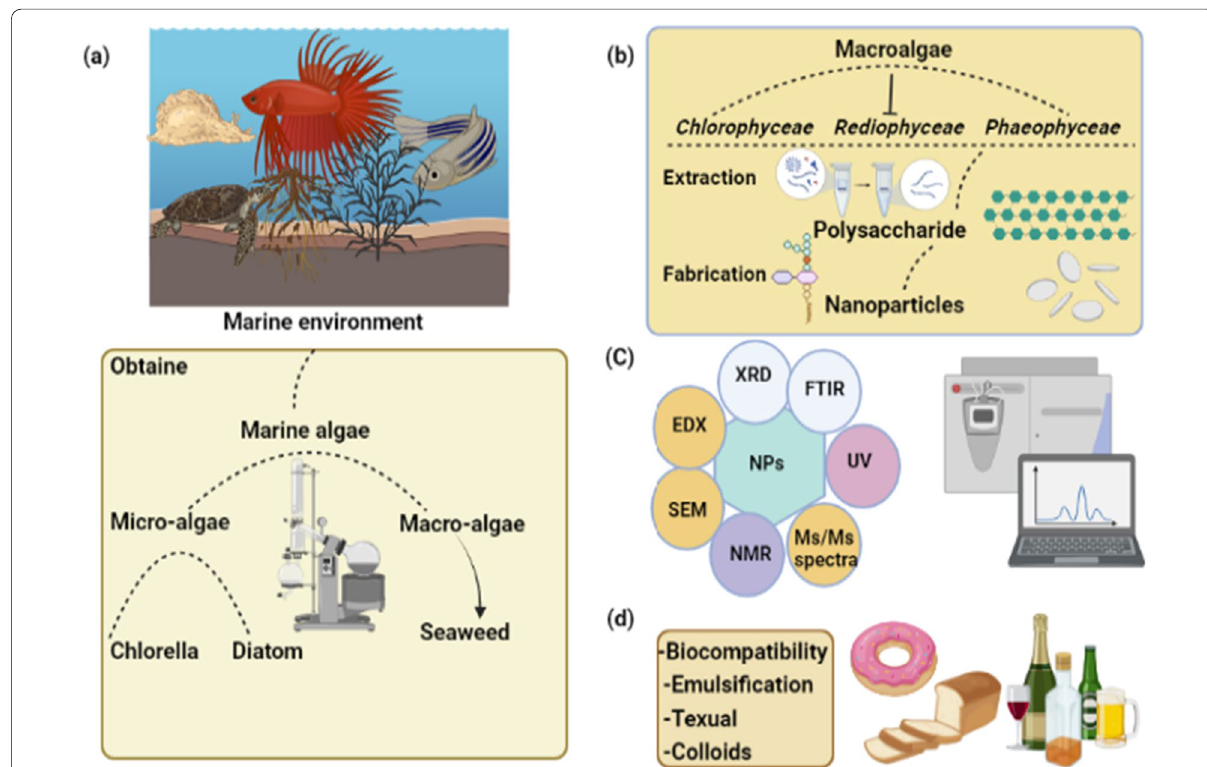
Fig. 1 a Whole diagram illustration of the origin of polysaccharides from algae, b synthesis of nanoparticles, c characterization of polysaccharides-based NPs, d and its application in different fields